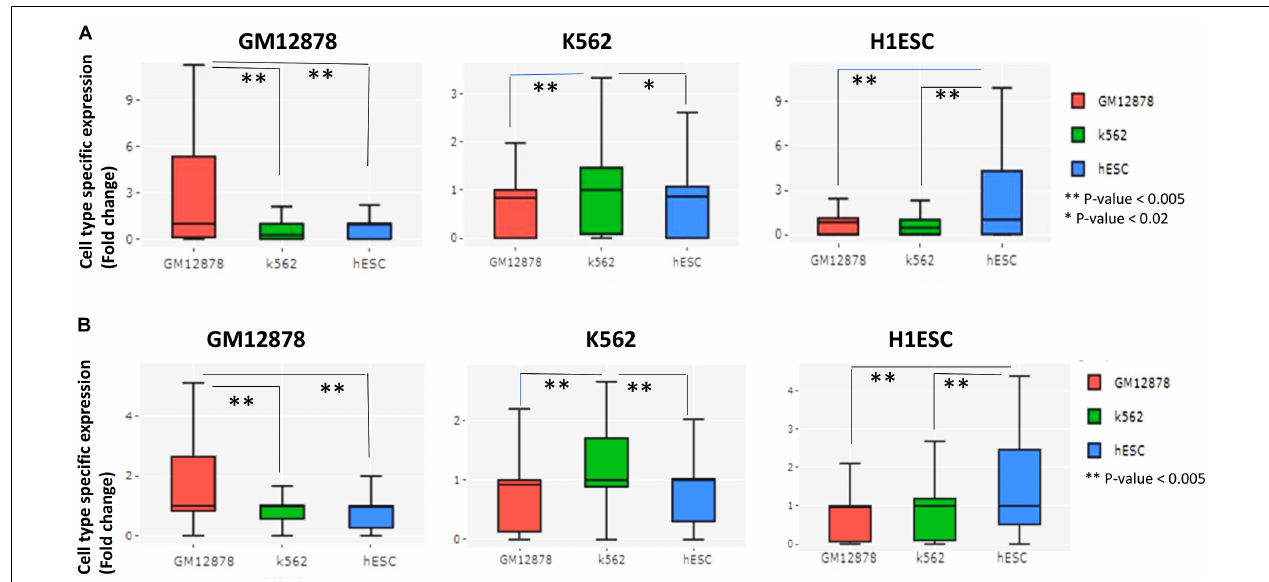
FIGURE 2 | Evaluation of prediction of cell-type-specific cis -regulation by scEChIA. (A) The cell-type-specific expression (fold-change above-median across different cell-types) of top 200 genes with the highest relative interactions in the respective cell-type of the figure panel. Such as, for the panel with label GM12878, top 200 genes with the highest relative number of chromatin-interaction in GM12878 cells (compared to K562 and hESC) were chosen and their expression values in three cell types (GM12878, K562, and hESC) are shown as box-plot. These results indicate that scEChIA can predict cis -regulatory interactions, which are associated with cell-type-specific expression. (B) The cell-type-specific expression of top 200 genes with the highest relative long-range interactions ( > 500 kbp) in the respective cell-type of the figure panel. Many long-range interactions ( > 500 kbp) predicted by scEChIA are also associated with cell-type-specific expression. *Significant, **Most Significant. p -values were calculated using Wilcoxon rank sum